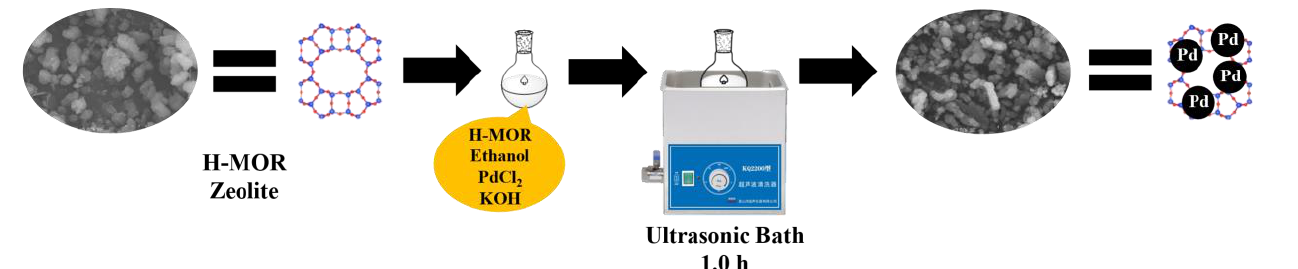
Figure 1. General procedure for the synthesis of Pd/H-MOR catalyst.